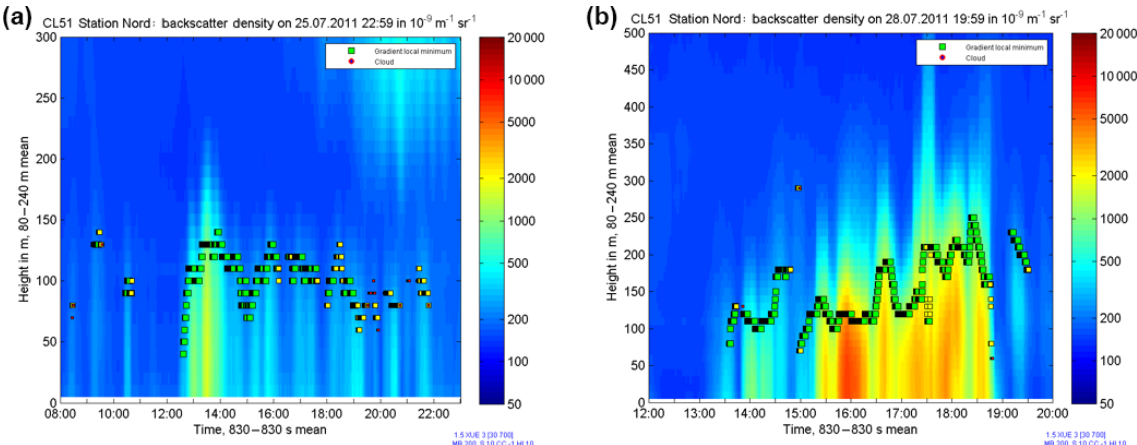
Figure 9. Backscatter profiles from Villum research station measured by a ceilometer on 25 July (a) and 28 July (b) in 2011. The bar to the right shows the backscatter density in 10 − 9 m − 1 sr − 1 . The squares show the height of the boundary